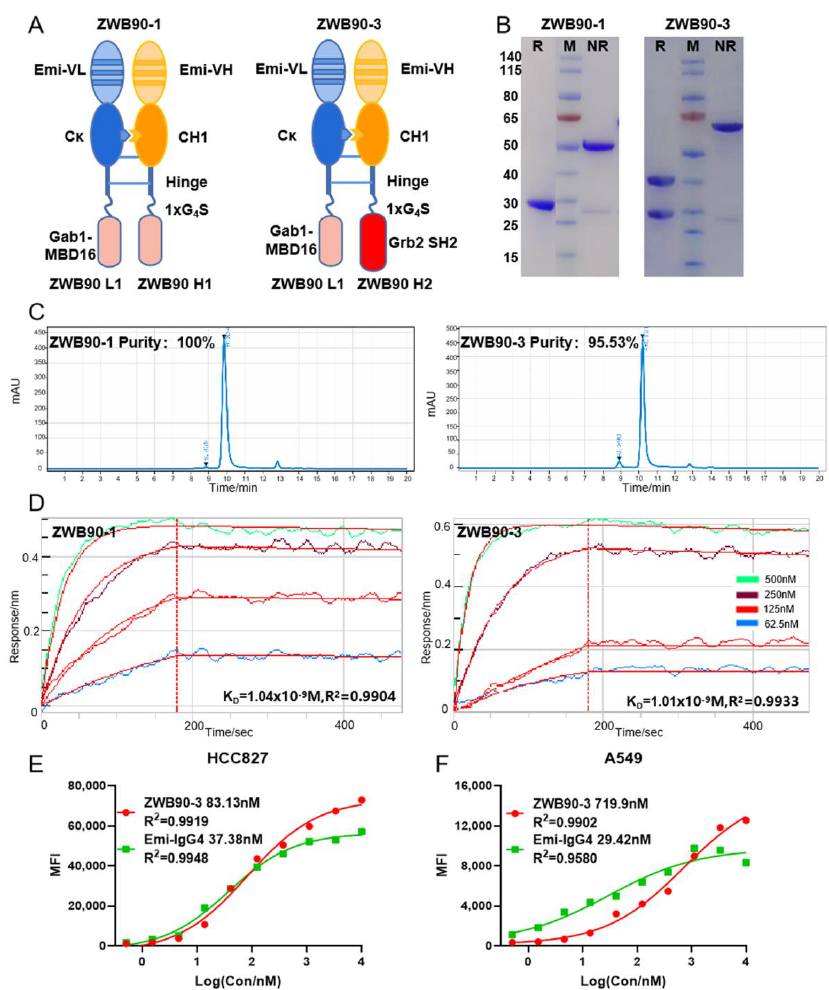
Figure 2. Generation and identification of ZWB90-1 and ZWB90-3. ( A ) Schematic representation of the design of ZWB90-1 and ZWB90-3. ( B ) Purities and molecular weights of ZWB90-1 and ZWB90-3 were detected by staining with Coomassie brilliant blue. Data showed expected band sizes and satisfactory purity levels. ( C ) The purities of ZWB90-1 and ZWB90-3 were also confirmed using the SEC. ( D ) ForteBio Octet determination of the affinities of ZWB90-1 and ZWB90-3 toward c-MET. The binding affinity parameter K D was calculated, as reported by ForteBio Data Analysis Software 8.0 (Fremont, CA, USA). ( E , F ) Dose-dependent binding of ZWB90-3 and Emi-IgG4 in HCC827 cells and A549 cells. The avidities were calculated using a four-parameter logistic curve analysis with GraphPad software (San Diego, CA, USA). R 2 is the coefficient of determination for estimating the goodness of the curve